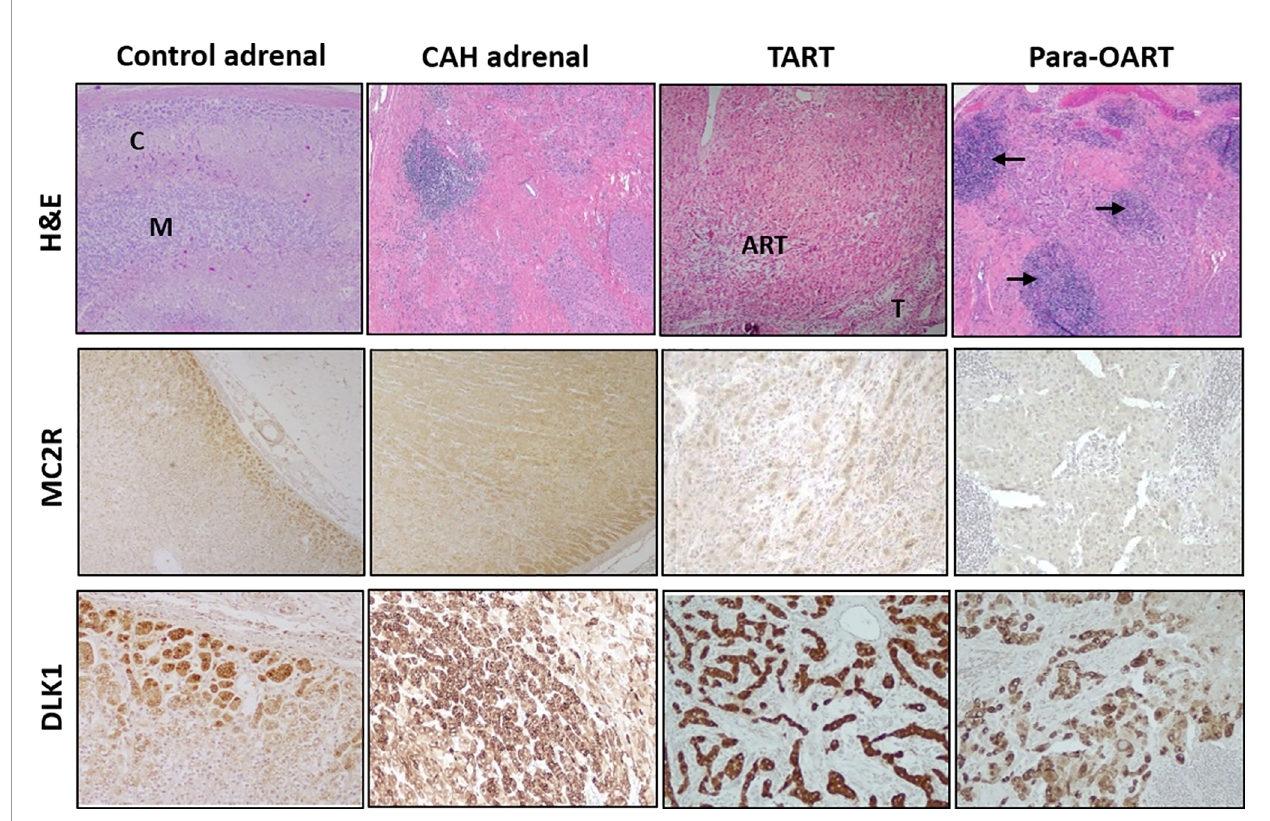
FIGURE 1 | Histological comparison of adrenal rest tumor tissue (ART) and adrenal glands from CAH patients. Hematoxylin and eosin (H&E) staining with low power (40X) observation of control adrenal, CAH adrenal and ARTs shows: control adrenal glands with clear zonation including distinct cortical (C) and medullary areas (M), CAH adrenal with hyperplastic adrenocortical cells and no clear zonation, testicular adrenal rest tissue (TART) consisting of eosinophilic epithelioid cells with abundant cytoplasm and testicular seminiferous tubules (T) in the periphery and para-ovarian adrenal rest tissue (Para-OART) cells with large nuclei and with lymphoid aggregates in between (arrows). Immunohistochemistry images show positive staining for adrenal- MC2R (adrenocorticotrophic hormone receptor: ACTHR) and DLK1 (delta like non-canonical notch ligand 1) protein expression in control adrenal, CAH adrenal (representative sample) and also in adrenal rest tissue (Original magni fi cation X40 for MC2R and X100 for